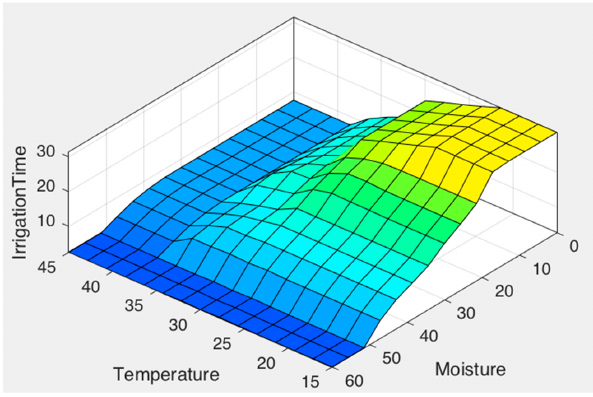
Figure 14. Relation between temperature and moisture.